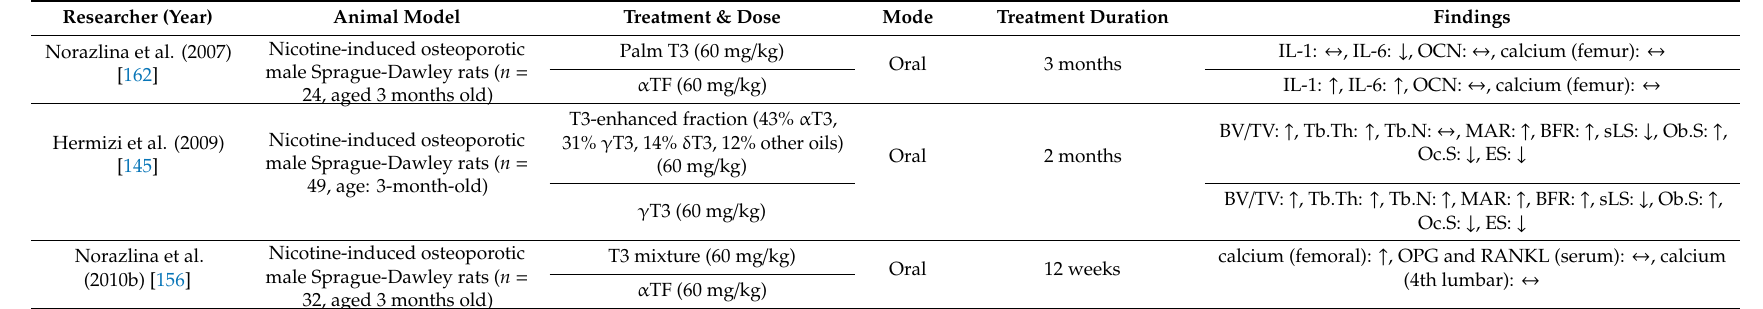
Table 9. E ff ects of T3 on osteoporosis in male